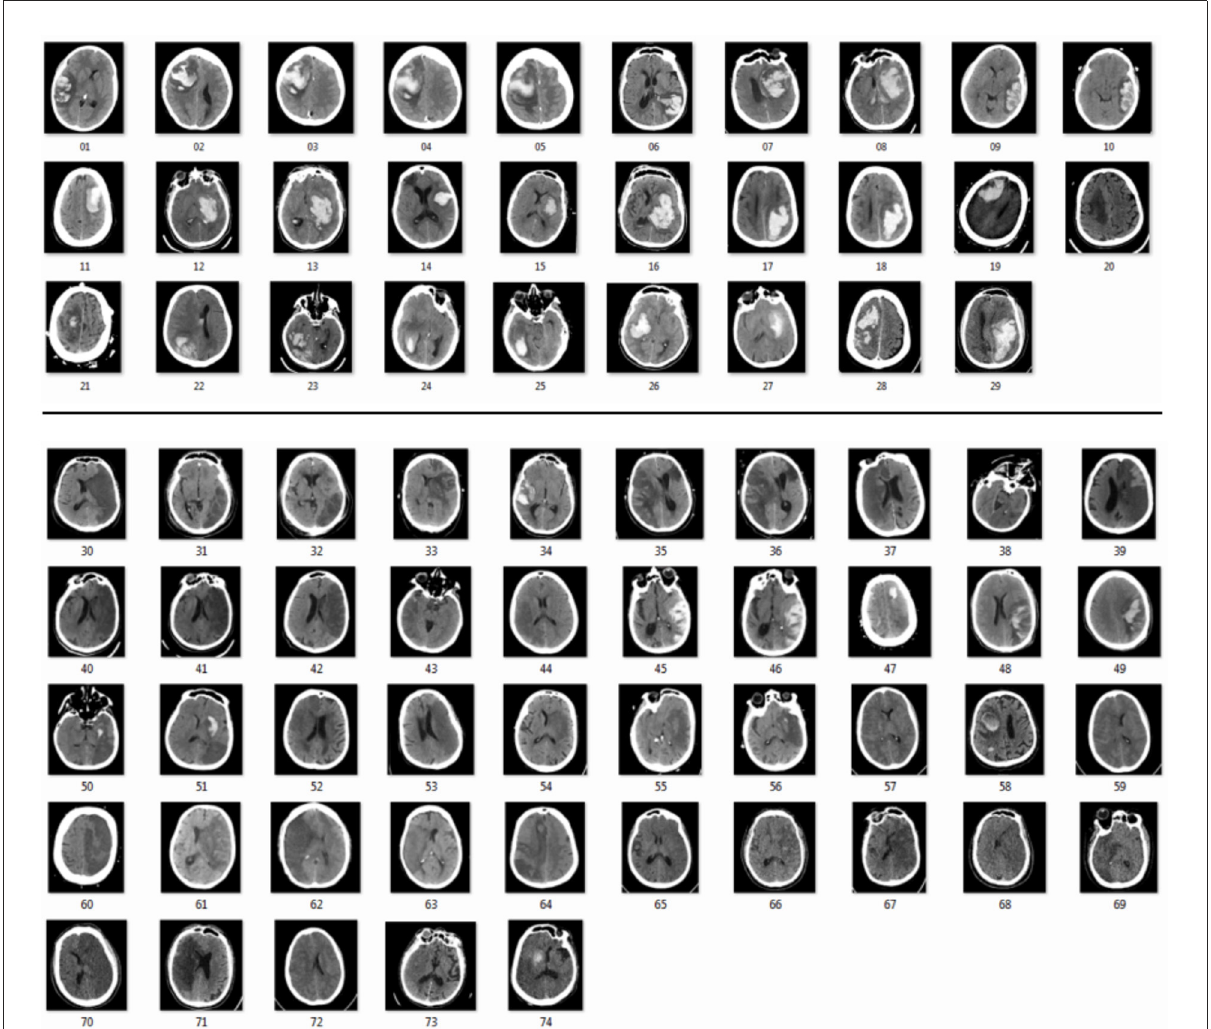
FIGURE1 Head computed tomography of intraparenchymal hemorrhage patients (01–29) and ischemic stroke patients (30–74) from four different sites from 2016 to